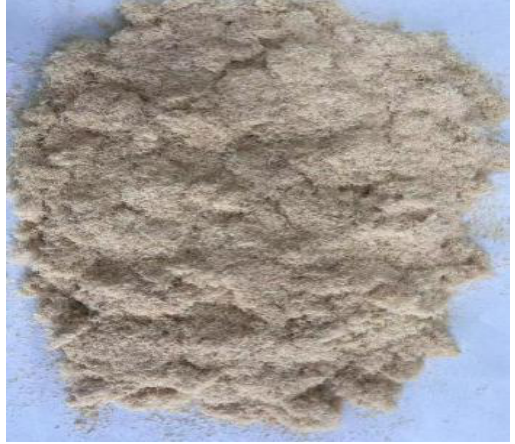
Figure 1. A real photo of ARP.